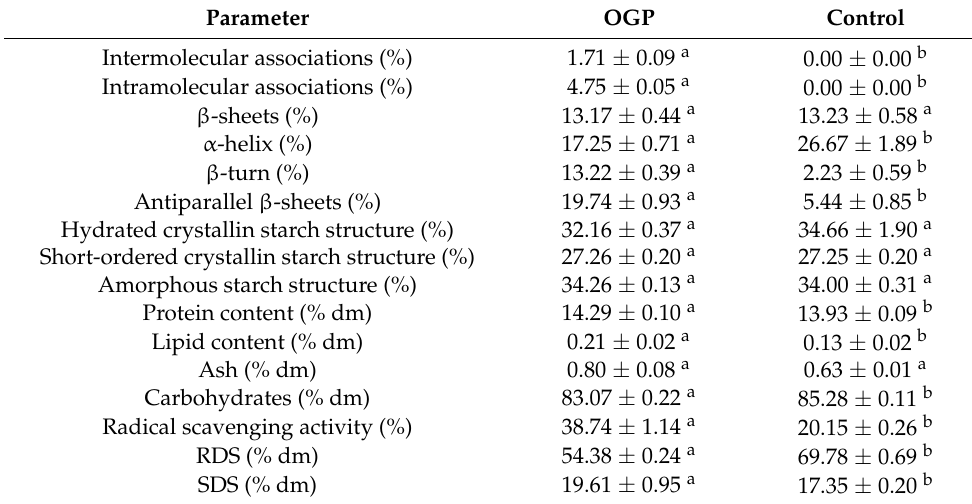
Table 3. Optimal and control product properties.